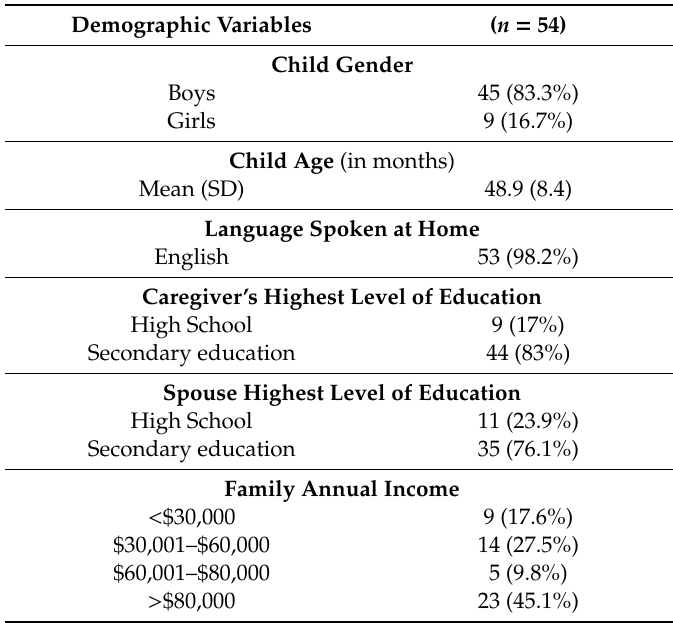
Table 1. Descriptive statistics and sociodemographic features of the